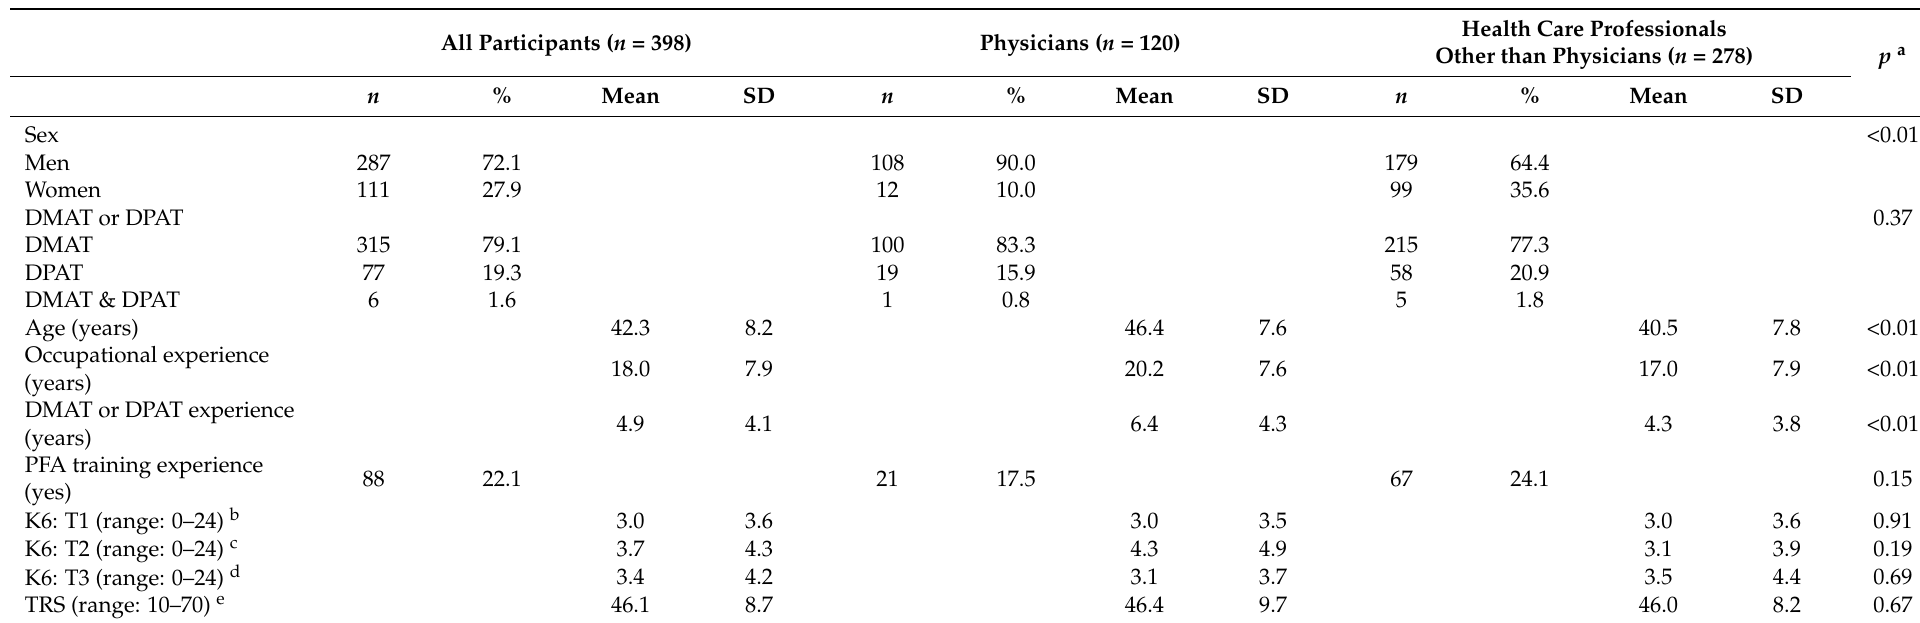
Table 1. Demographic characteristics of participants ( n =